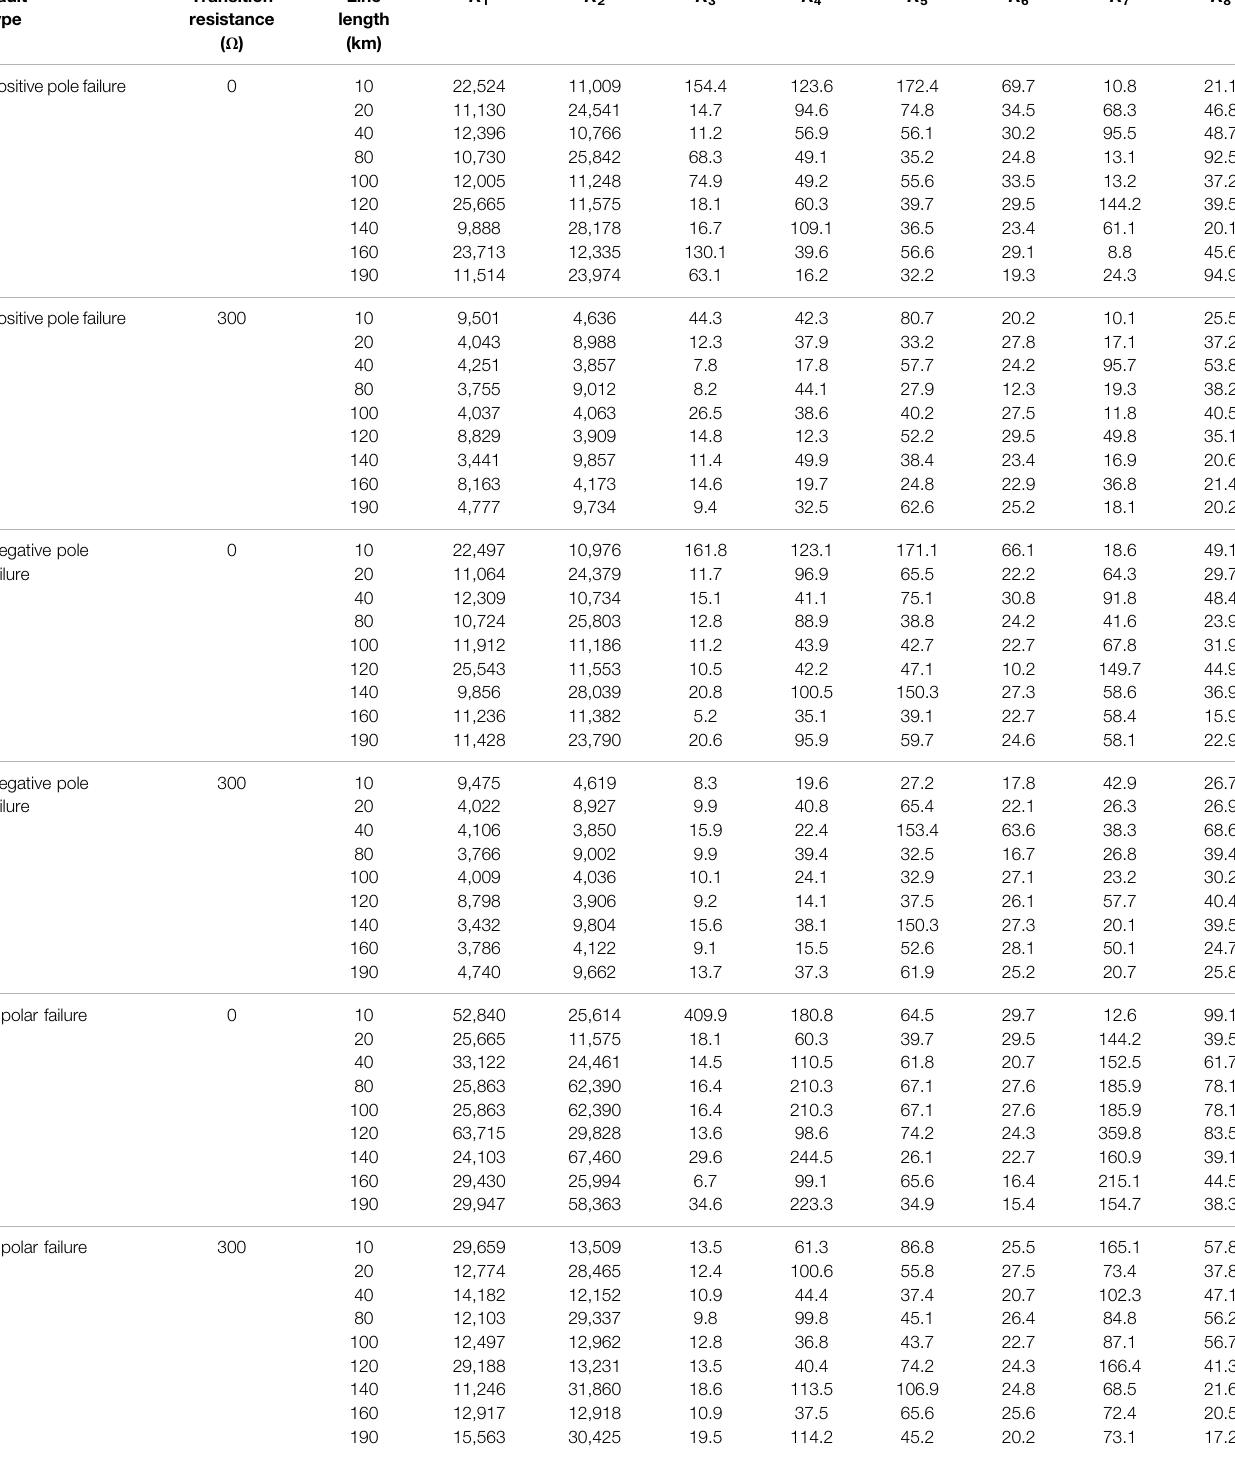
TABLE 1 | Line 1 combined power SOD conversion coef fi